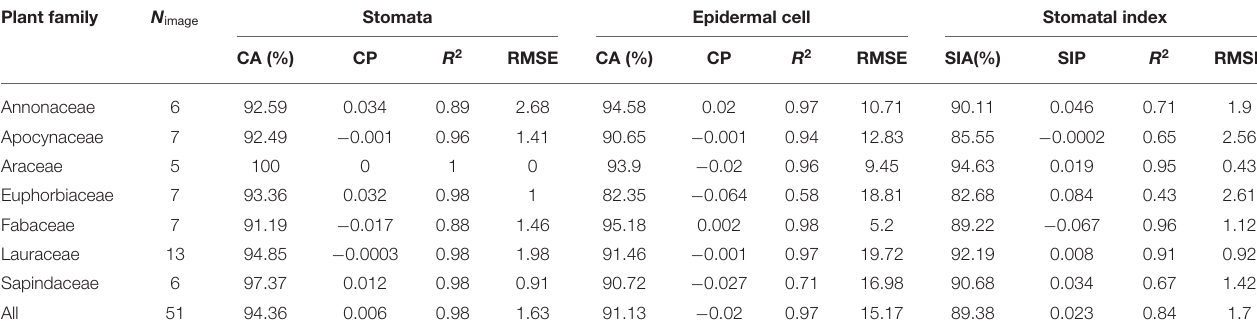
TABLE 5 | Summary of performance evaluations of the proposed pipeline on the cuticle dataset. Plant family